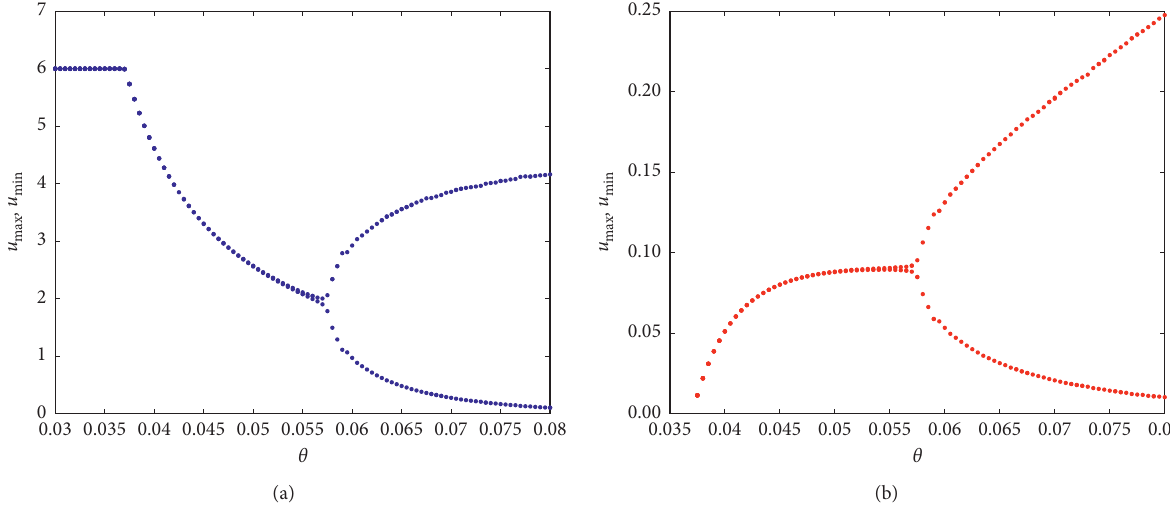
Figure 10: Bifurcation diagram with respect to conversion term θ for predator-prey system (19) with Beddington–DeAngelis-type response function. Rest of parameters are r